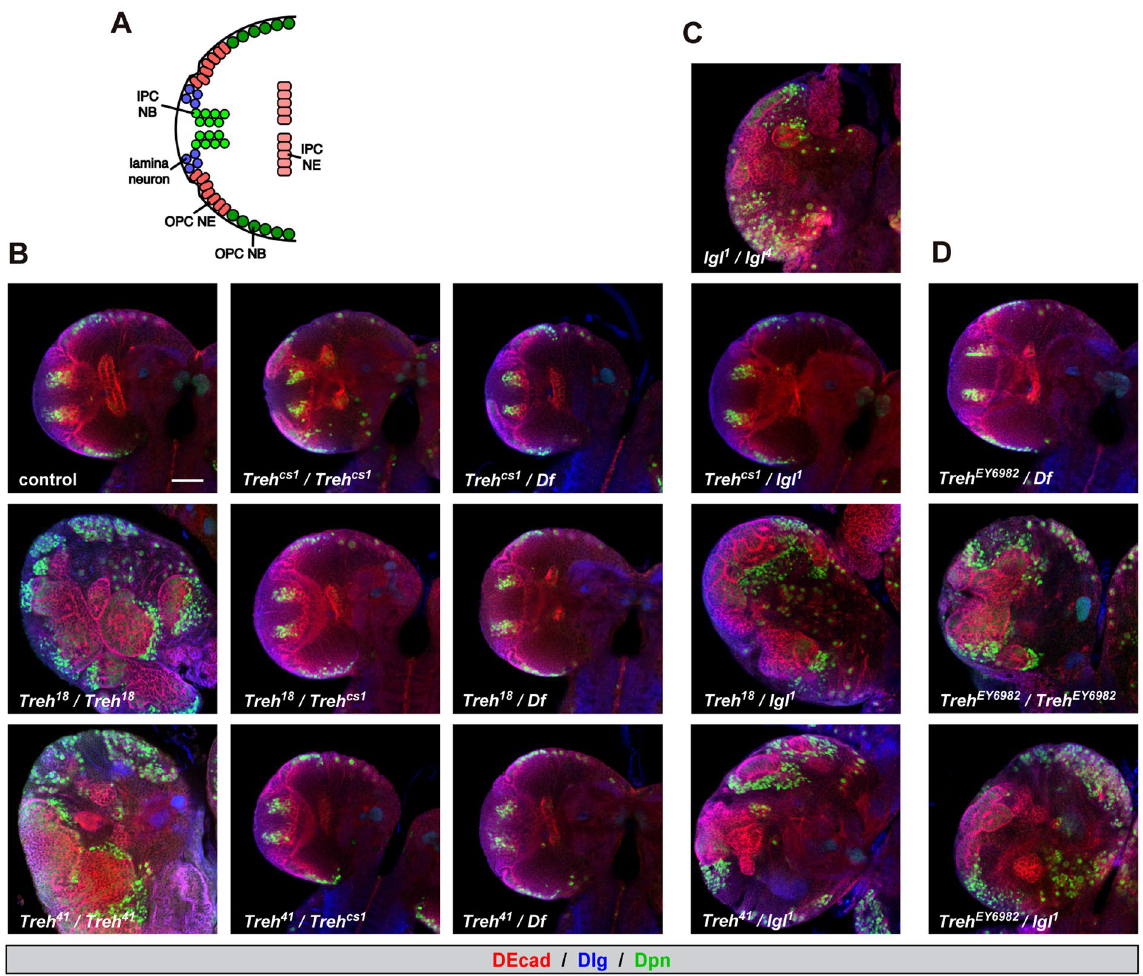
Figure 1. Treh mutants do not cause disorganization of the optic lobe in the central nervous system. ( A ) Schematic diagram of the frontal view of the larval optic lobe. Lamina neuron, OPC neuroepithelial cell (OPC NE), OPC neuroblast (OPC NE), IPC neuroepithelial cell (IPC NE), and IPC neuroblast (IPC NB) are shown. ( B ) Treh cs1 null mutants do not cause disorganization of the optic lobe in the central nervous system in homozygotes and in trans to a chromosomal deficiency. Wandering late-third instar larvae were stained for Deadpan (Dpn, green) to label neuroblasts and for Discs large (Dlg, blue) and DE-Cadherin (DE-cad, red) to label epithelial cells. Single medial confocal sections of the optic lobe for each genotype are shown. ( C ) Second site mutation(s) in the lgl locus is responsible for the disorganization phenotype of Treh 18 and Treh 41 mutants in the optic lobe neuroepithelia. ( D ) Original P -element insertion allele of Treh 18 and Treh 41 retains second site mutation(s) in the lgl locus. Scale bars = 50 μ